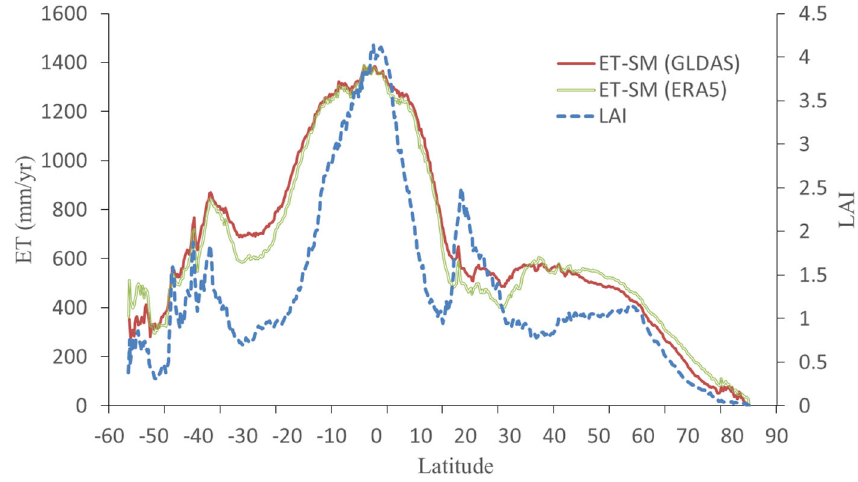
Figure 2. The variation of ET with latitude in multi − year average value.